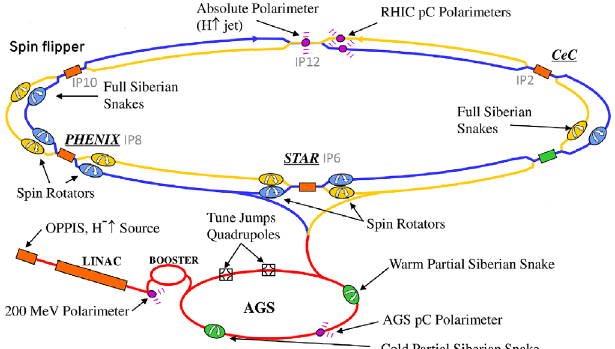
FIG. 1. Schematic layout of RHIC polarized beam complex. RHIC consists of two rings, respectively, known as Blue and Yellow. Beams go clockwise (CW) in the former, and counter- clockwise (CCW) in the latter. Snakes are located at 9 o ’ clock and 3 o ’ clock, rotator pairs flank IP6 and